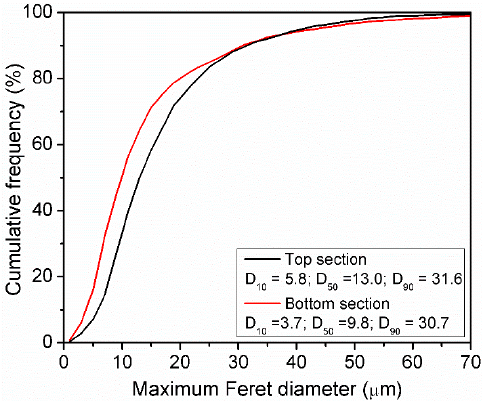
Figure 4. Particle segregation in a powder bed from the top and bottom sections of the building plate.